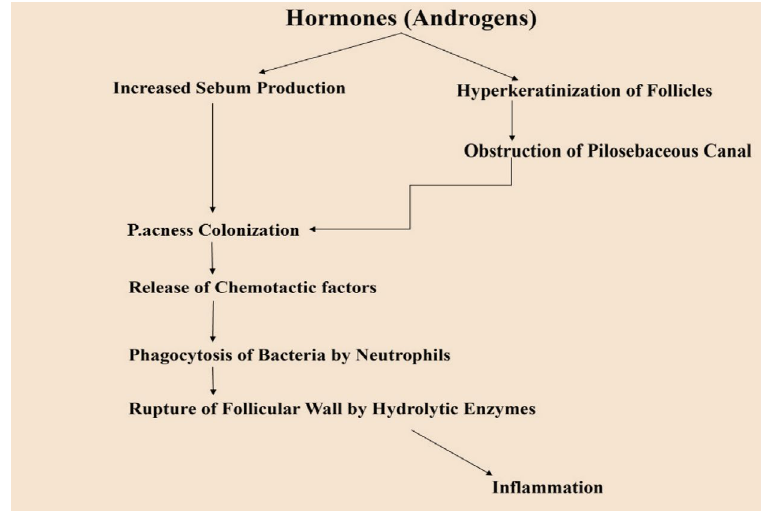
Fig. 2. Schematic of factors which are involved in the pathogenesis of Acne. Androgens affect sebum production and hyperkeratini- zation of follicles that cause colonization of P.acness in skin follicles and release of chemotactic factors from the bacteria which cause inflammation as the first stage of acne development in